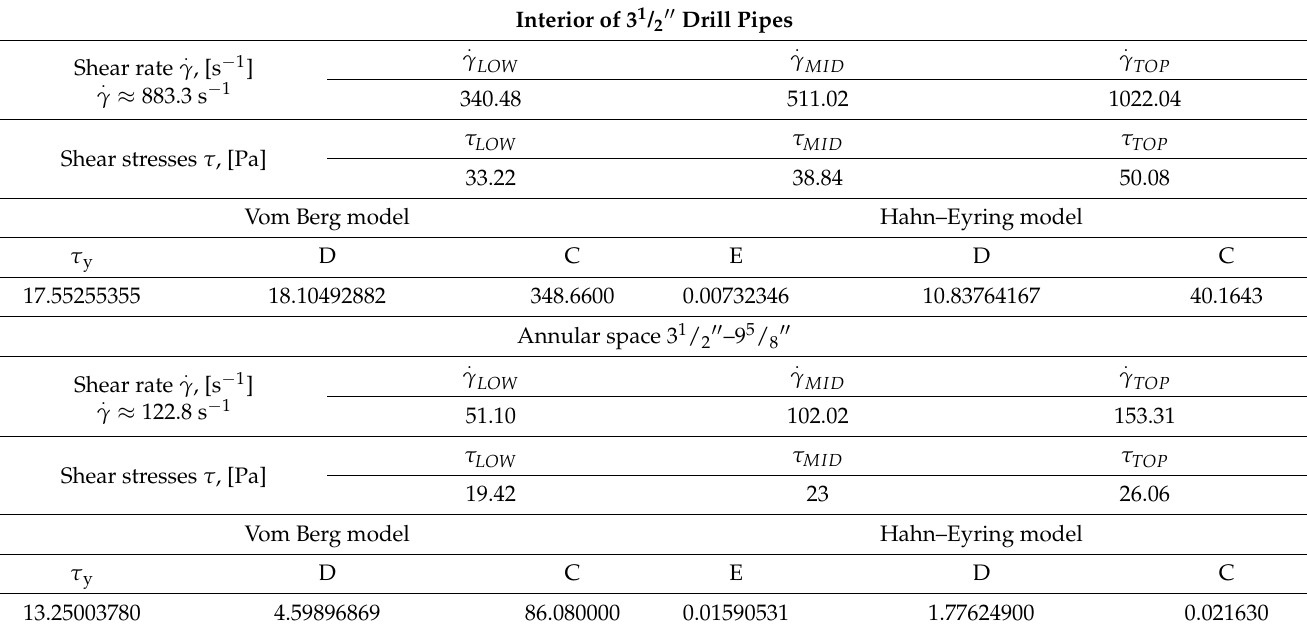
Table 8. Results of calculations with regard to the rheological parameters of the tested drilling mud. Interior of 3 1 / 2 (cid:48)(cid:48) Drill